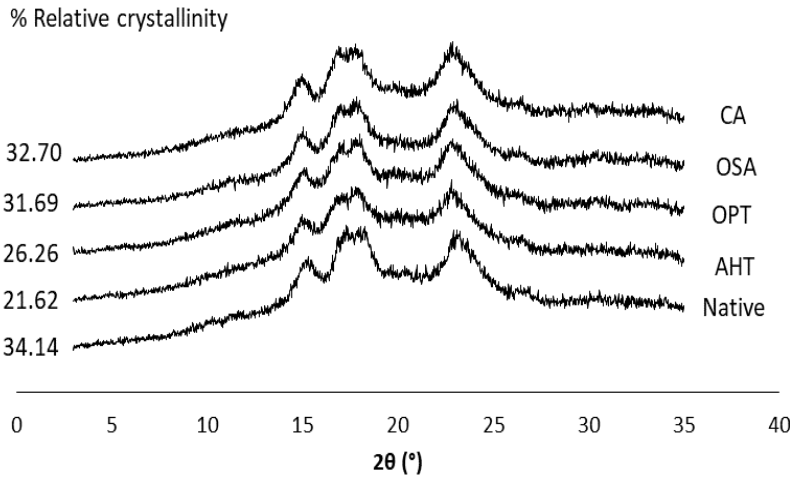
Figure 3. X-ray diffraction patterns of native and various modified sago starches. AHT = autoclave- heating treatment, OPT = osmotic-pressure treatment, OSA = octenyl-succinic anhydride, CA = citric acid cross-linking.